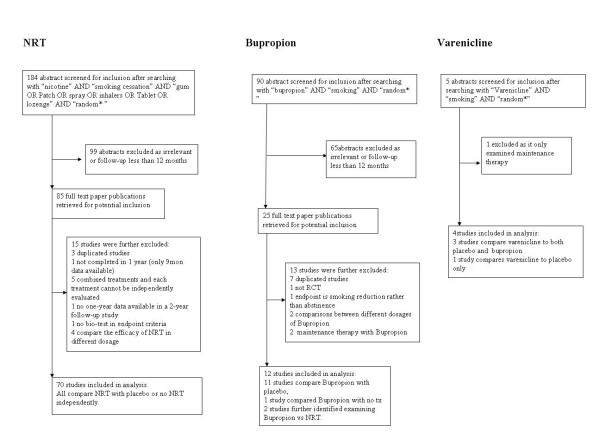
Flowcharts of study searches.